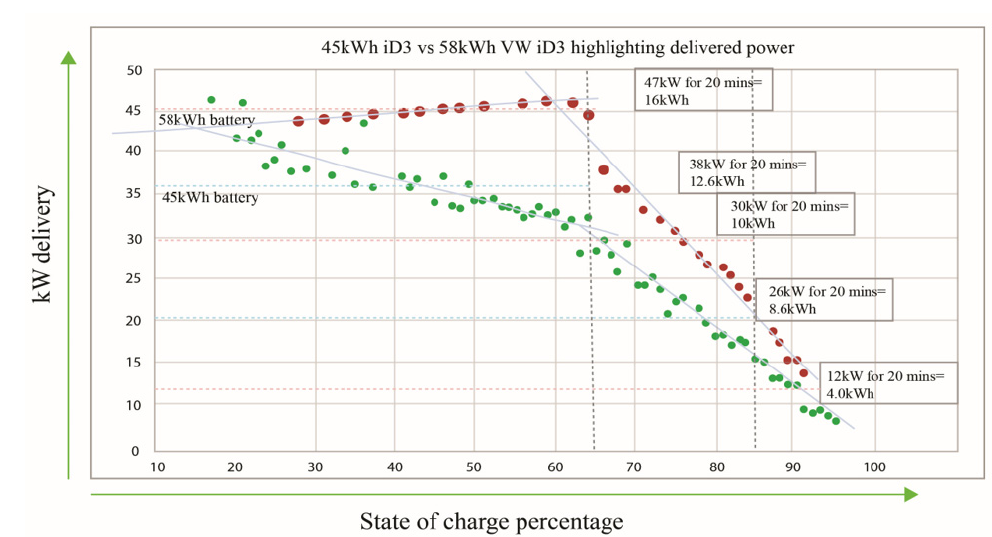
Figure 5. Power delivery as the state of charge increases, using averages for the 45 kWh VW iD3 (green dots) and 58 kWh VW iD3 (red dots).